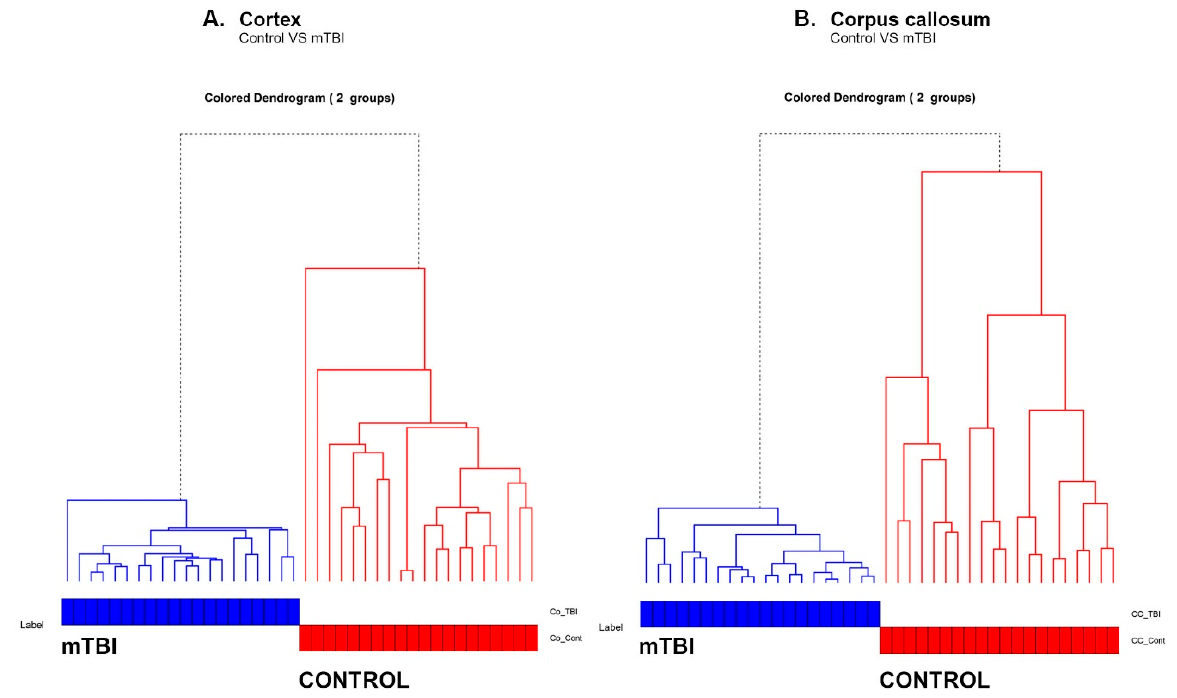
Figure 6. Hierarchy cluster analysis (HCA) showing the heterogeneity of the spectra belonging to the control and mTBI groups due to the bimolecular changes in ( A ) Co and ( B ) CC regions.